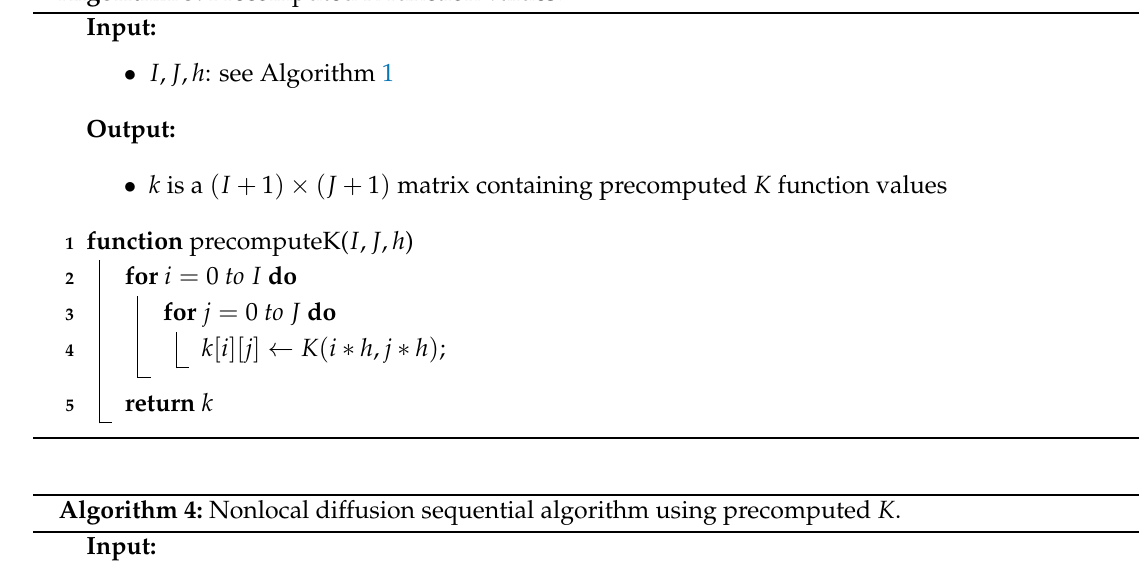
Algorithm 3: Precomputed K function values.